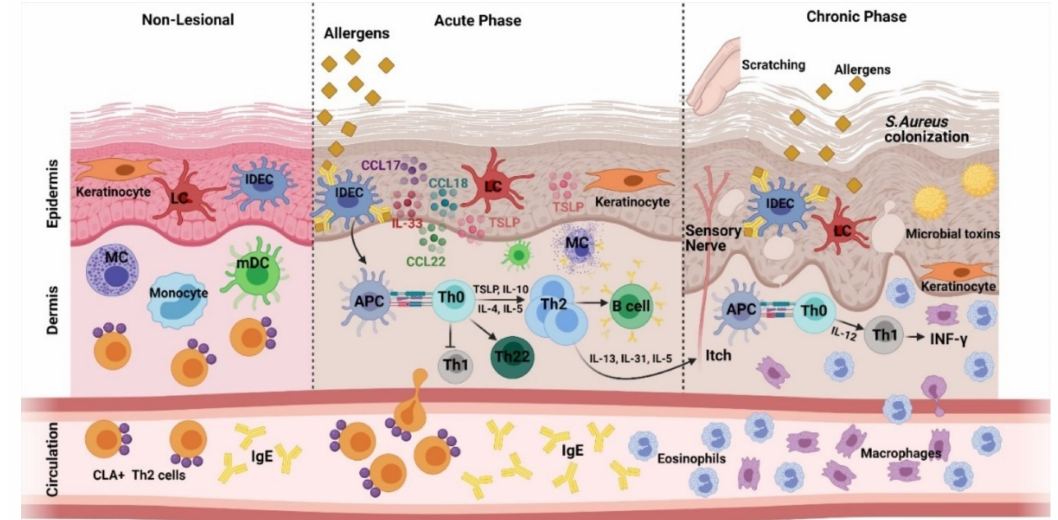
Figure 1. Stage-based pathophysiology of AD indicating various responses and roles of innate and adaptive immune cells during different stages of AD. During the allergic reaction, epidermal dendritic cells with specific IgE bind to the high-affinity receptors of IgE, and Langerhans cells and dermal DC take up allergens and antigens. The type 2 cytokines along with B cells and other Th cytokines directly promote pruritus through sensory nerve activation. Chronicity leads a progressive increase of keratinocyte-derived and various immune-cell-derived cytokines, which further promote itch by various